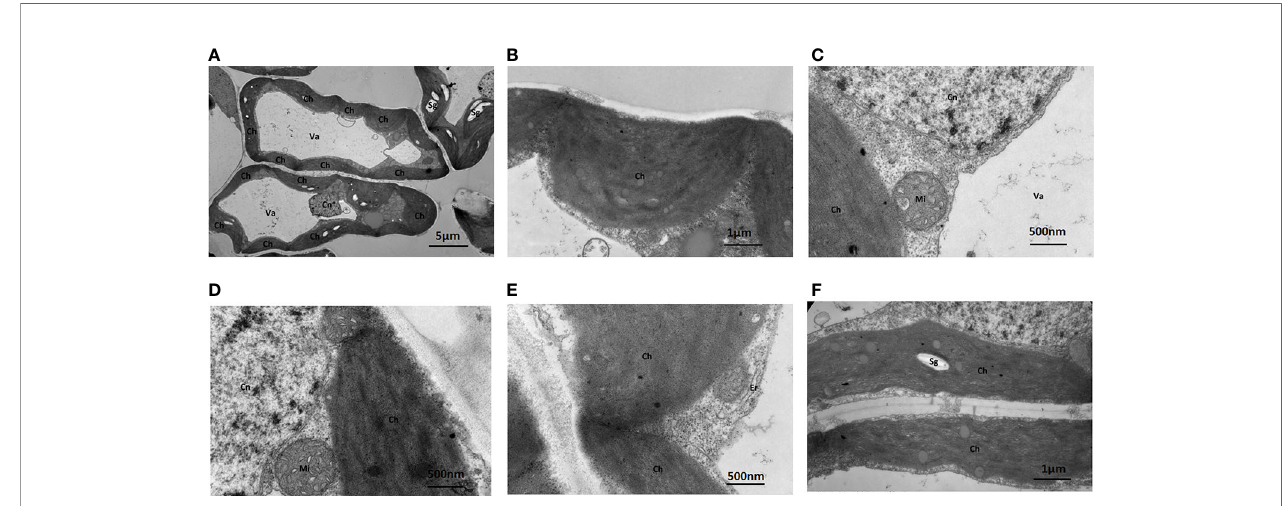
FIGURE 5 | Effect of solid MS culture medium without Na 2 MoO 4 on cell morphology and ultrastructure in leaf of strawberry seedlings. Transmission electron micrographs of leaves in strawberry seedlings examined under a JEOL-1200EX TEM TEM. (A) The cellular structure (B) The swollen chloroplast. (C) The membrane system is damaged and the membrane structure is unclear. (D) Cn, Mi, Ch is unclear (E) Irregular chloroplasts and Oedema of the endoplasmic reticulum (F) Sg in the chloroplasts. Ch, chloroplast; Cn, cell nucleus; Er, endoplasmic reticulum; Mi, mitochondria; Va, vacuole; Sg, starch grain.